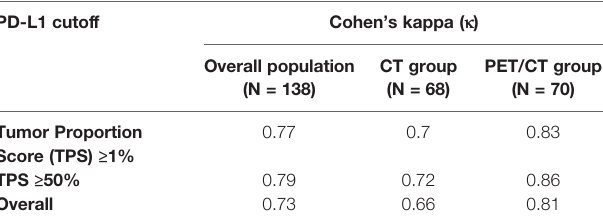
TABLE 2 | Cohen ’ s k for concordance between percutaneous biopsy and matched surgical specimens based on TPS. PD-L1